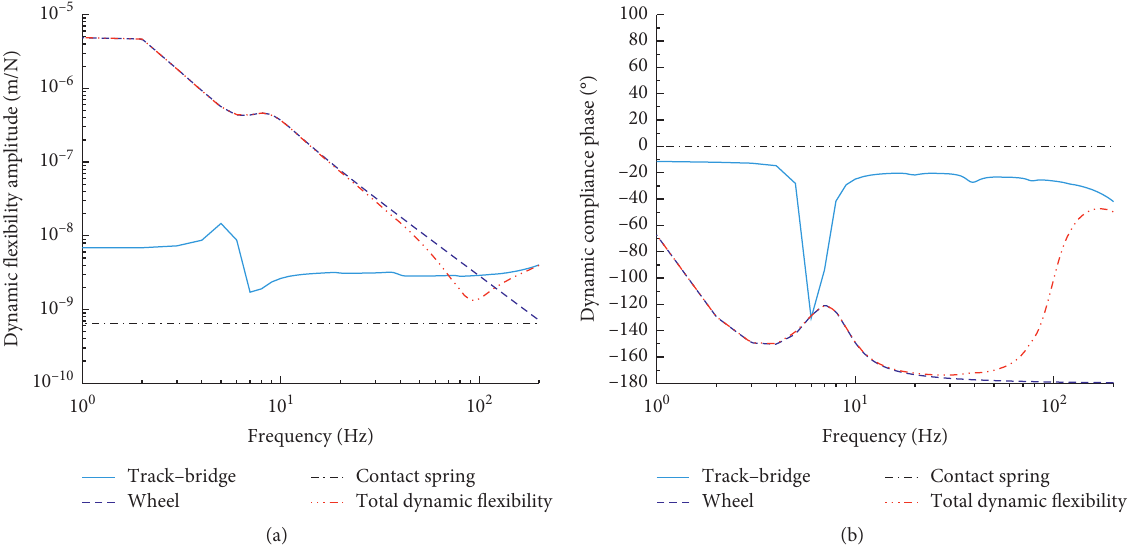
Figure 13: Dynamic compliance amplitude and phase of vehicle-track-bridge system with constant resistance elastic pad at − 30 ° C: (a) amplitude; (b)